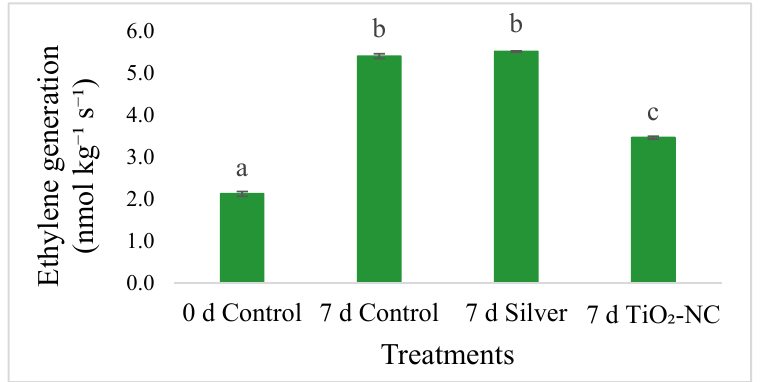
Figure 4. Changes in ET evolution of Capsicum fruit under silver and TiO 2 -NC with respect to control during 0 d and 7 d of postharvest storage at 25 °C. Vertical bars showing SE ± 1 ( n = 3) on each column and letters above bars indicate statistical variations between treatments based on one way ANOVA ( p ≤ 0.05).